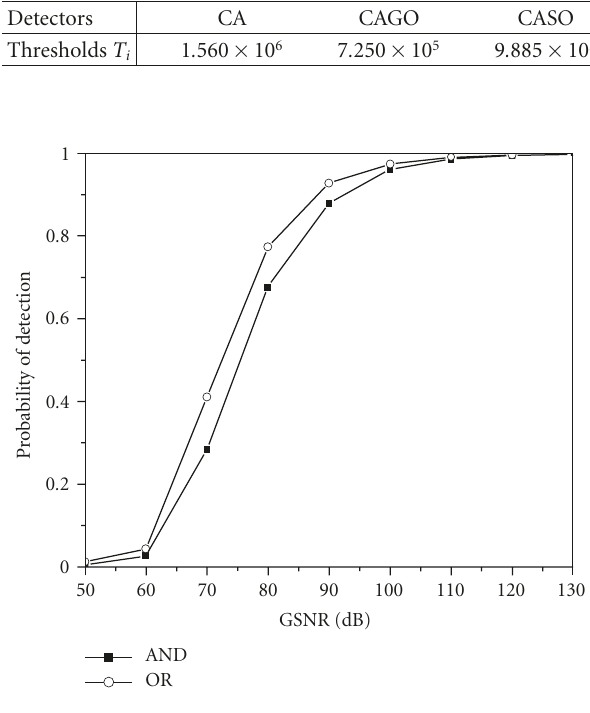
Figure 5: Probability of detection of two distributed CA-CACFAR system in homogeneous Pearson background, adopting the “AND” and “OR” fusion rules. N 1 = 32, N 2 = 32. P fa = 10 − 4 .